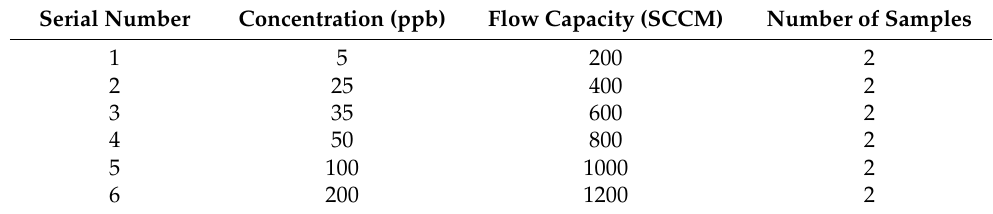
Table 2. Gas concentration and pump suction flow